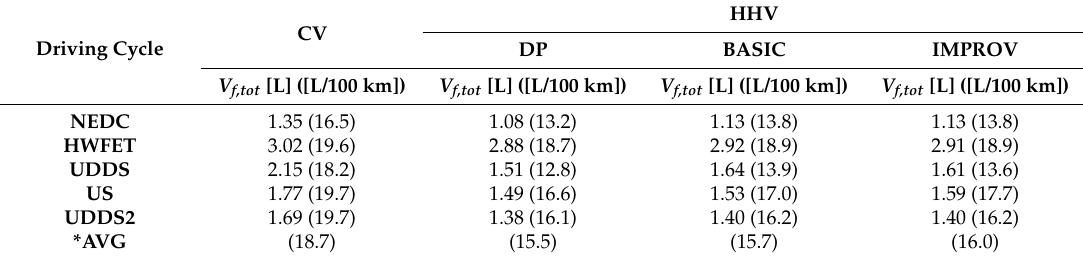
Table 3. Absolute (L) and average (L/100 km) fuel consumption for conventional vehicle (CV) and for hydraulic hybrid vehicle (HHV: DP, BASIC, IMPROV) in case of different driving cycles.